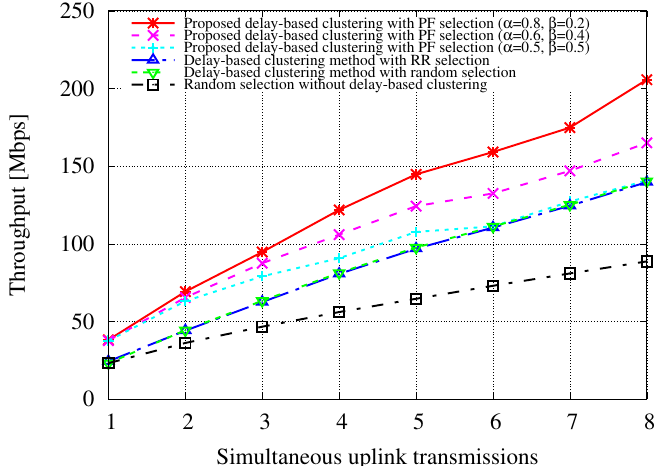
Figure 4. Network throughput performance ( S = 200).